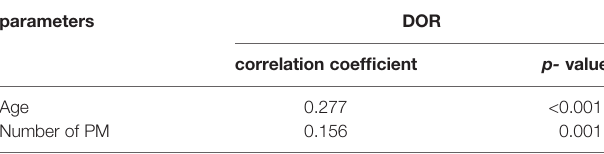
TABLE 5 | Correlation analyses of PM number and age with DOR (by Kendall ’ s Tau-B).